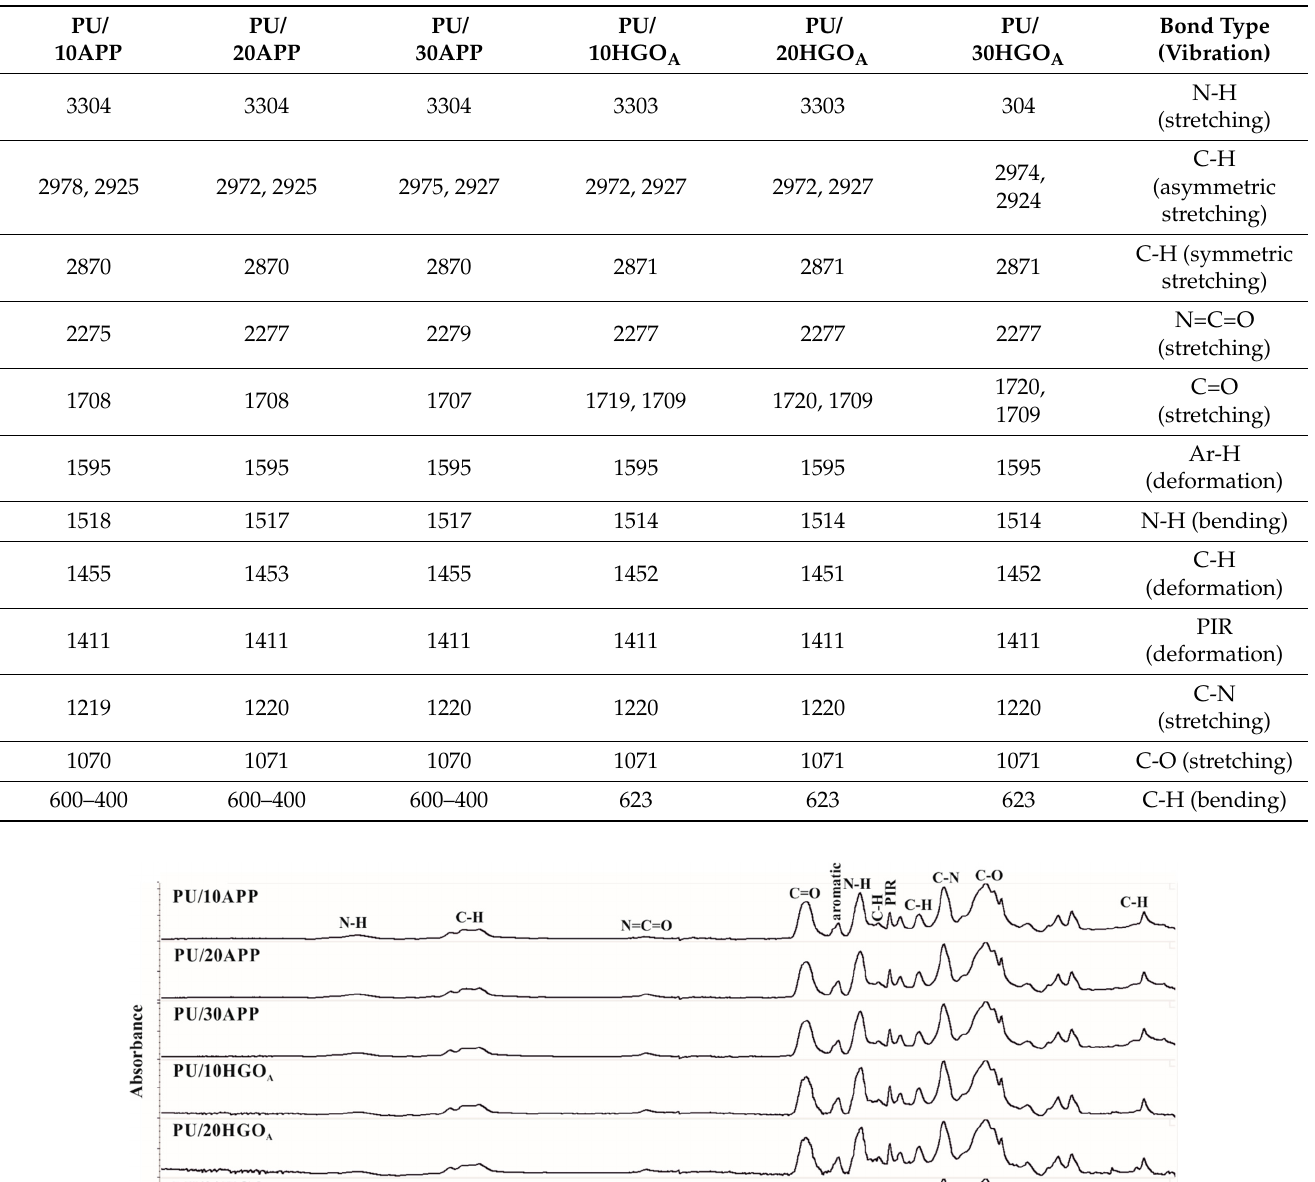
Table 4. Maximum values of absorption signals for PU/APP and PU/HGO A foams.